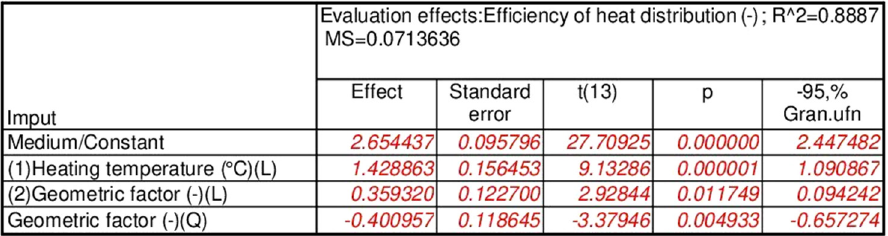
Figure 11. Results of the analysis of the effect of statistically significant input quantities on the response function value, applicable to the pure PCM heat